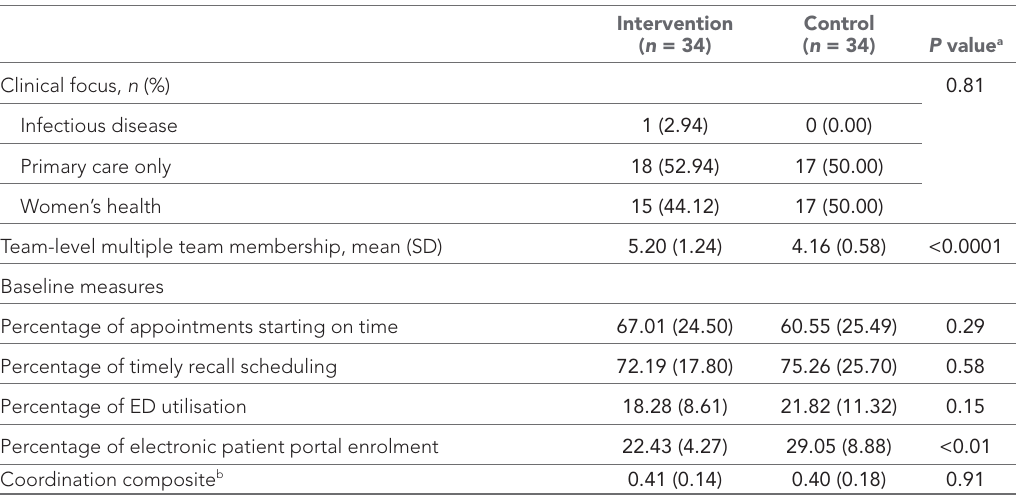
Table 2 Team characteristics, overall and intervention group